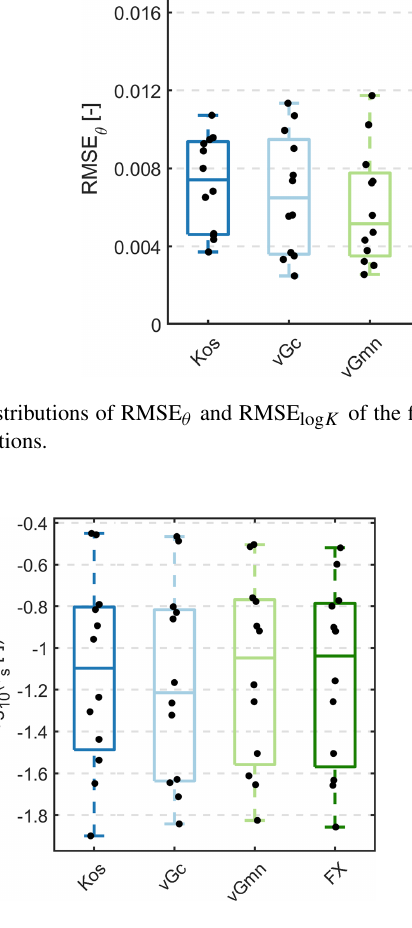
Figure 4. Distribution of fitted values of τ s for 4 different retention